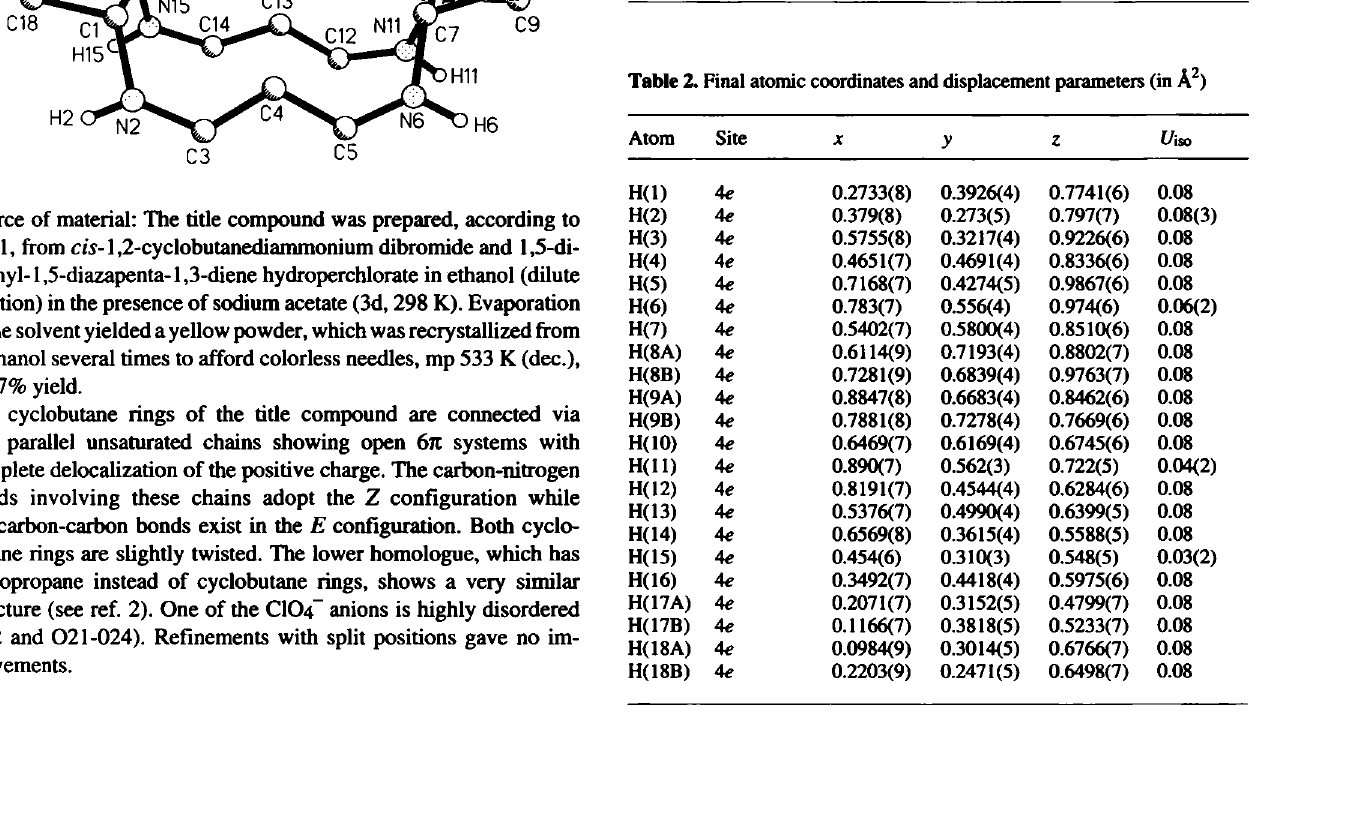
Table 1. Parameters used for the X-ray data collection Crystal: